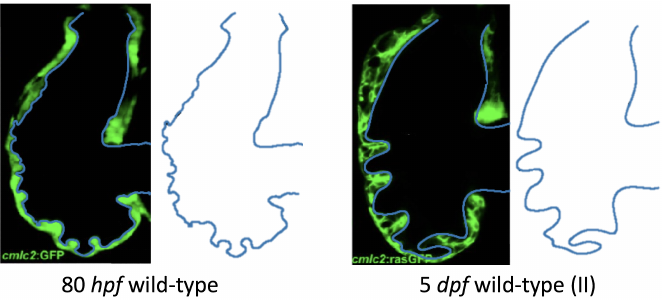
Figure A1. Extracting biologically realistic geometries of trabeculated geometries at different time-points from [21]. Geometries are given for a WT zebrafish at 80 hpf and 5 dpf